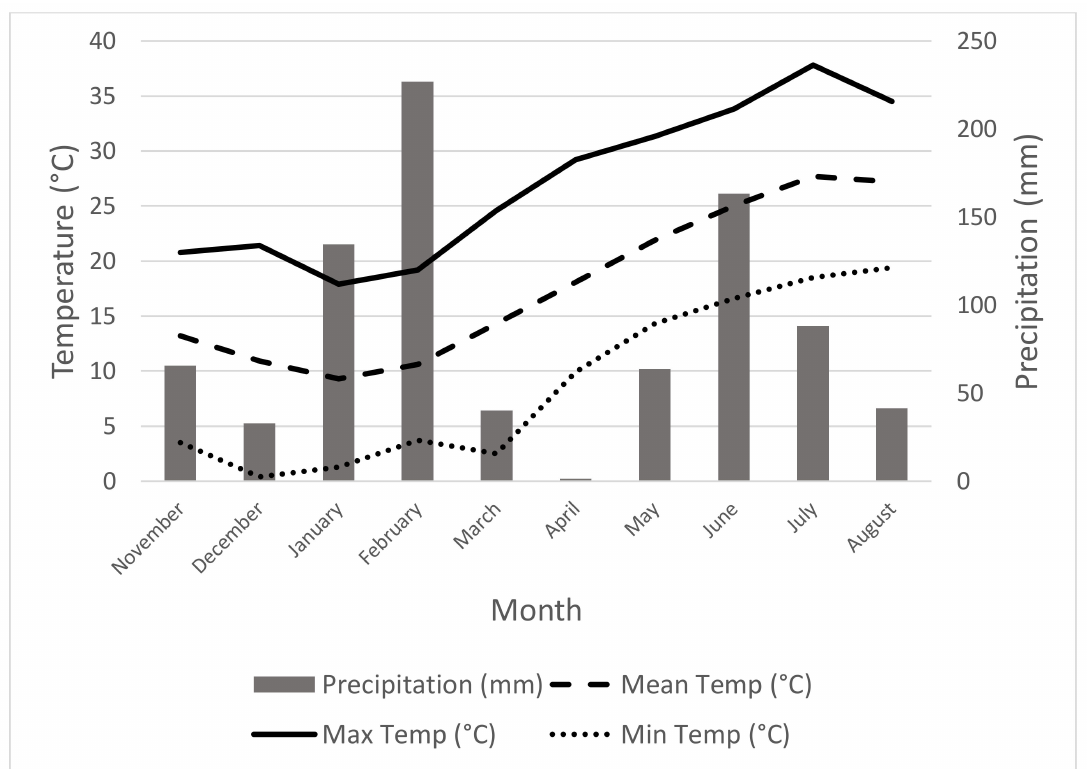
Figure 2. Climate conditions during the experimental period (Mean temperature ( ◦ C); Max temperature ( ◦ C); Min temperature ( ◦ C); Precipitation